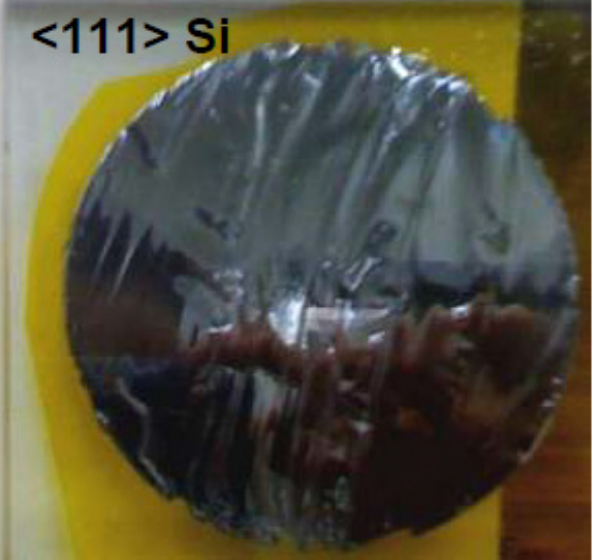
Figure 5. Spalling of Si(111), wafer <111> from the ingot of a diameter of 100 mm.